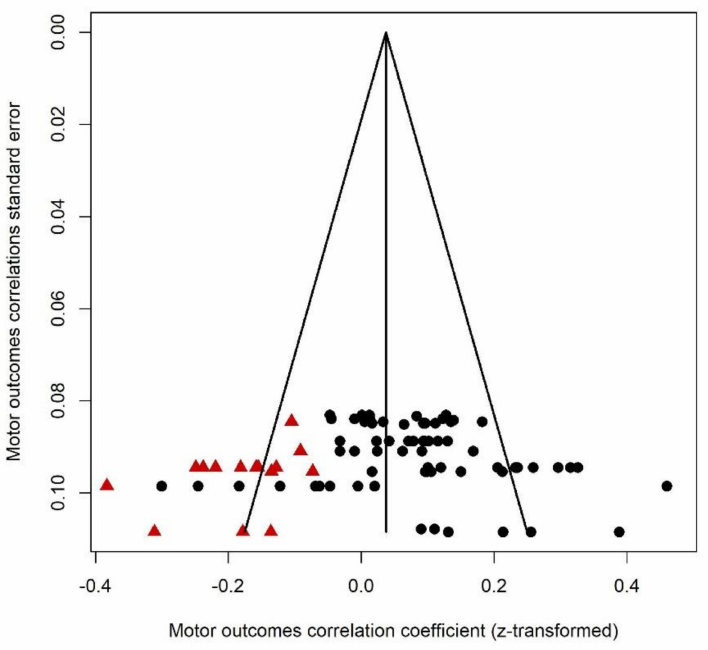
Figure 9. Motor outcomes funnel plot. Fifteen positive effect sizes were added and represented by red triangles.